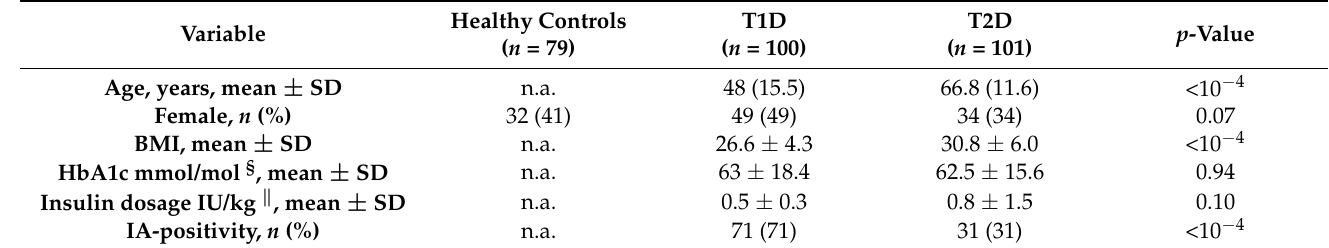
Table 1. Demographics and clinical data of the study population.